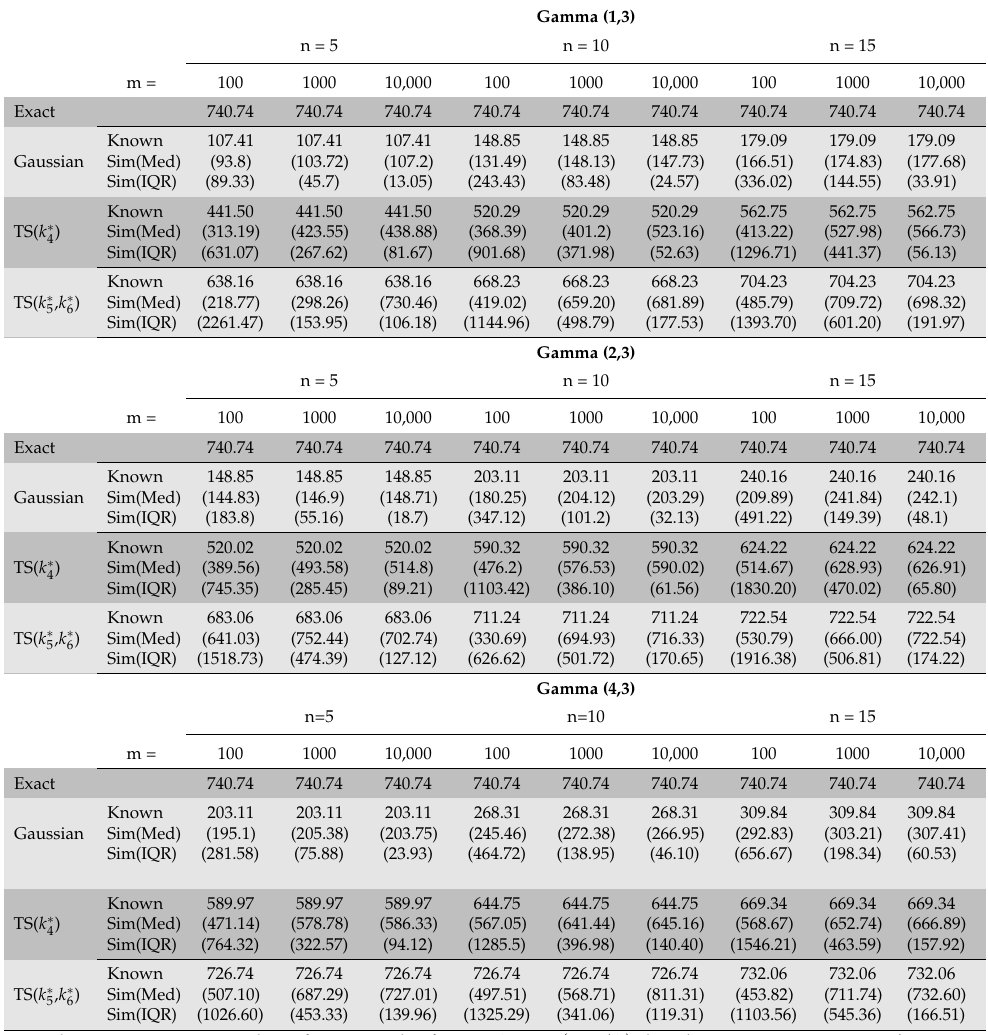
Table 4. In-control ARLs for the UCL of an ¯ X -chart on a Gamma ( γ ,1/ λ ) distributed